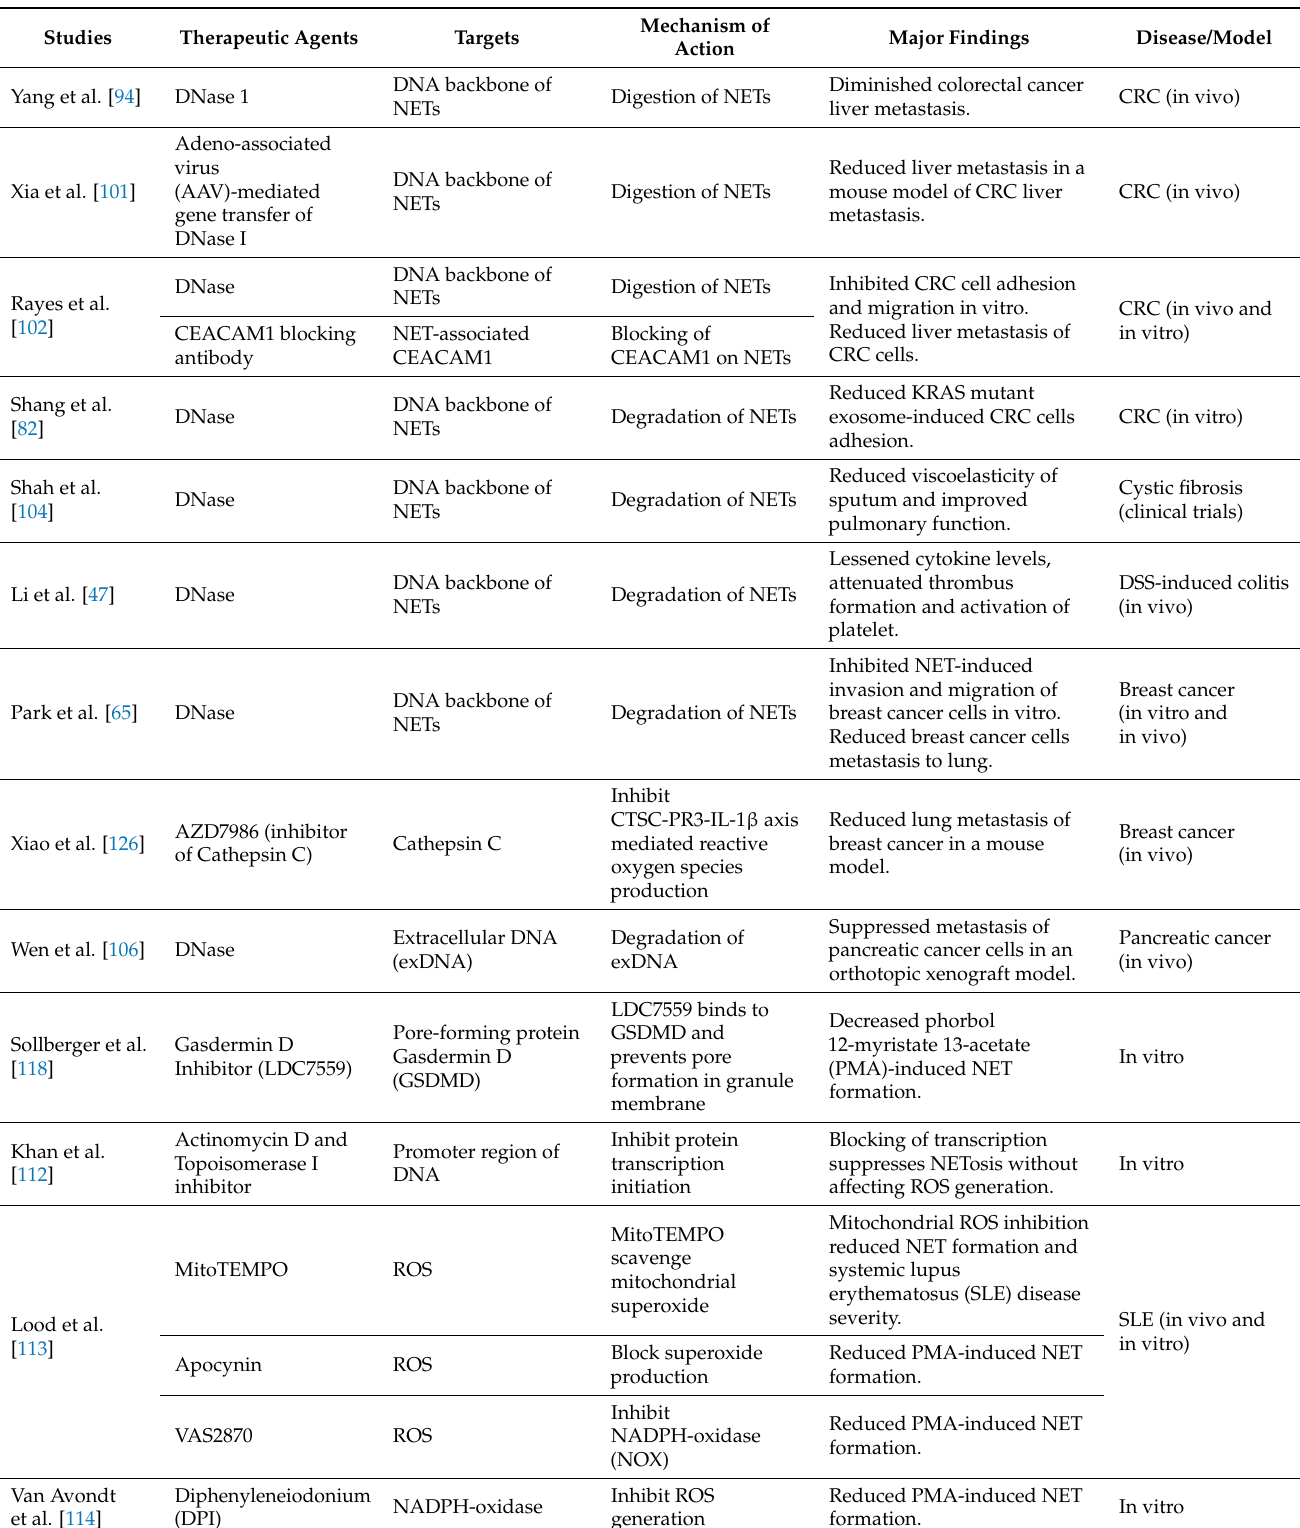
Table 2. List of studies targeting NETs in various